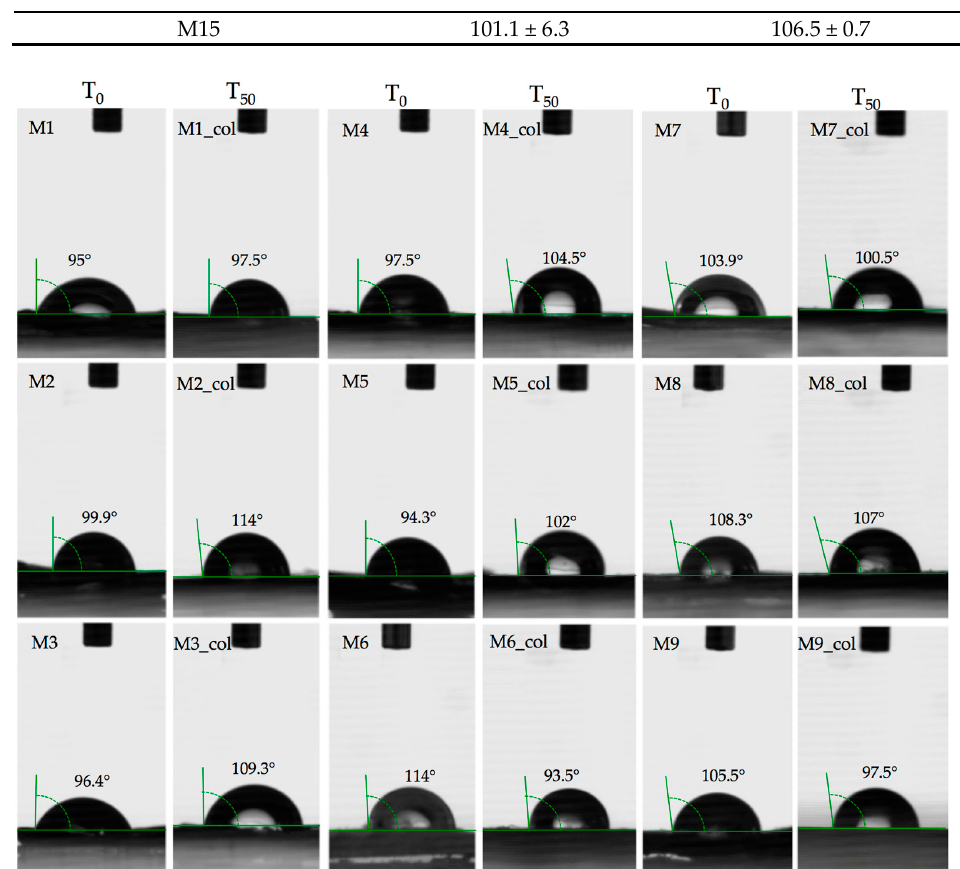
Figure 17. Contact angle of PET composites before and after collagen accumulation at 50 days (T 50 ).